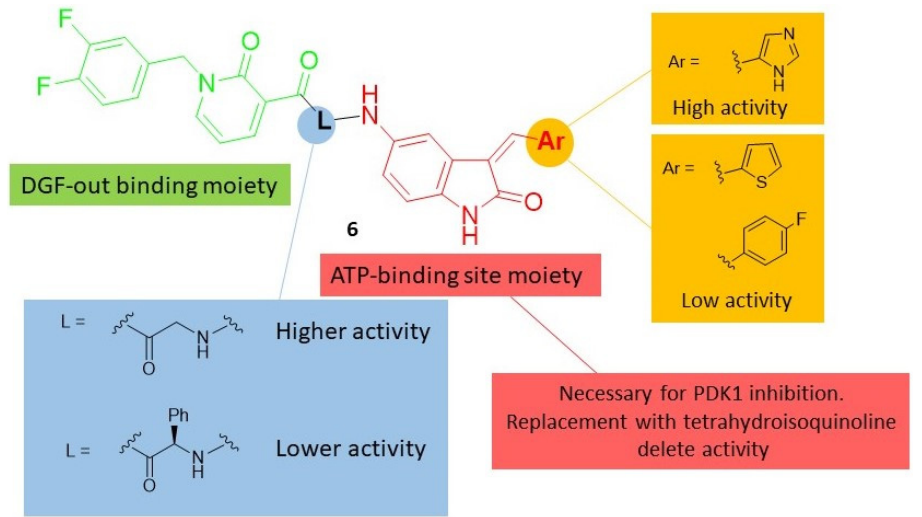
Figure 2. SAR [51] summary for PDK1 inhibition activity of indole-based derivatives 6 .